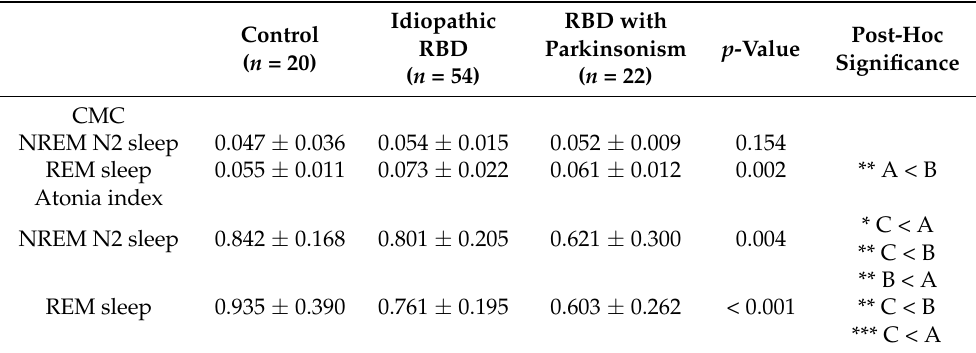
Table 3. Corticomuscular coherence and atonia index in controls, patients with idiopathic RBD, and combined RBD with